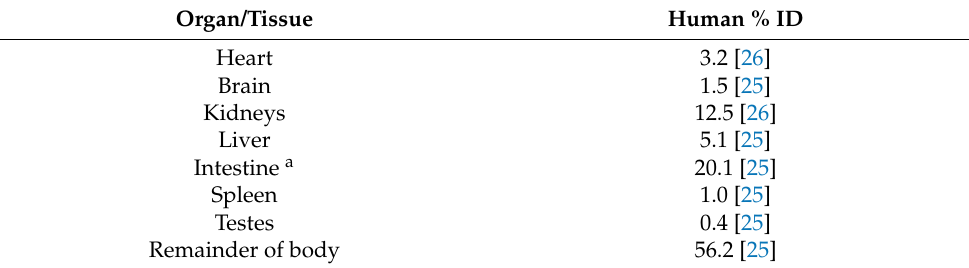
Table 5. 208 Tl human tissue %